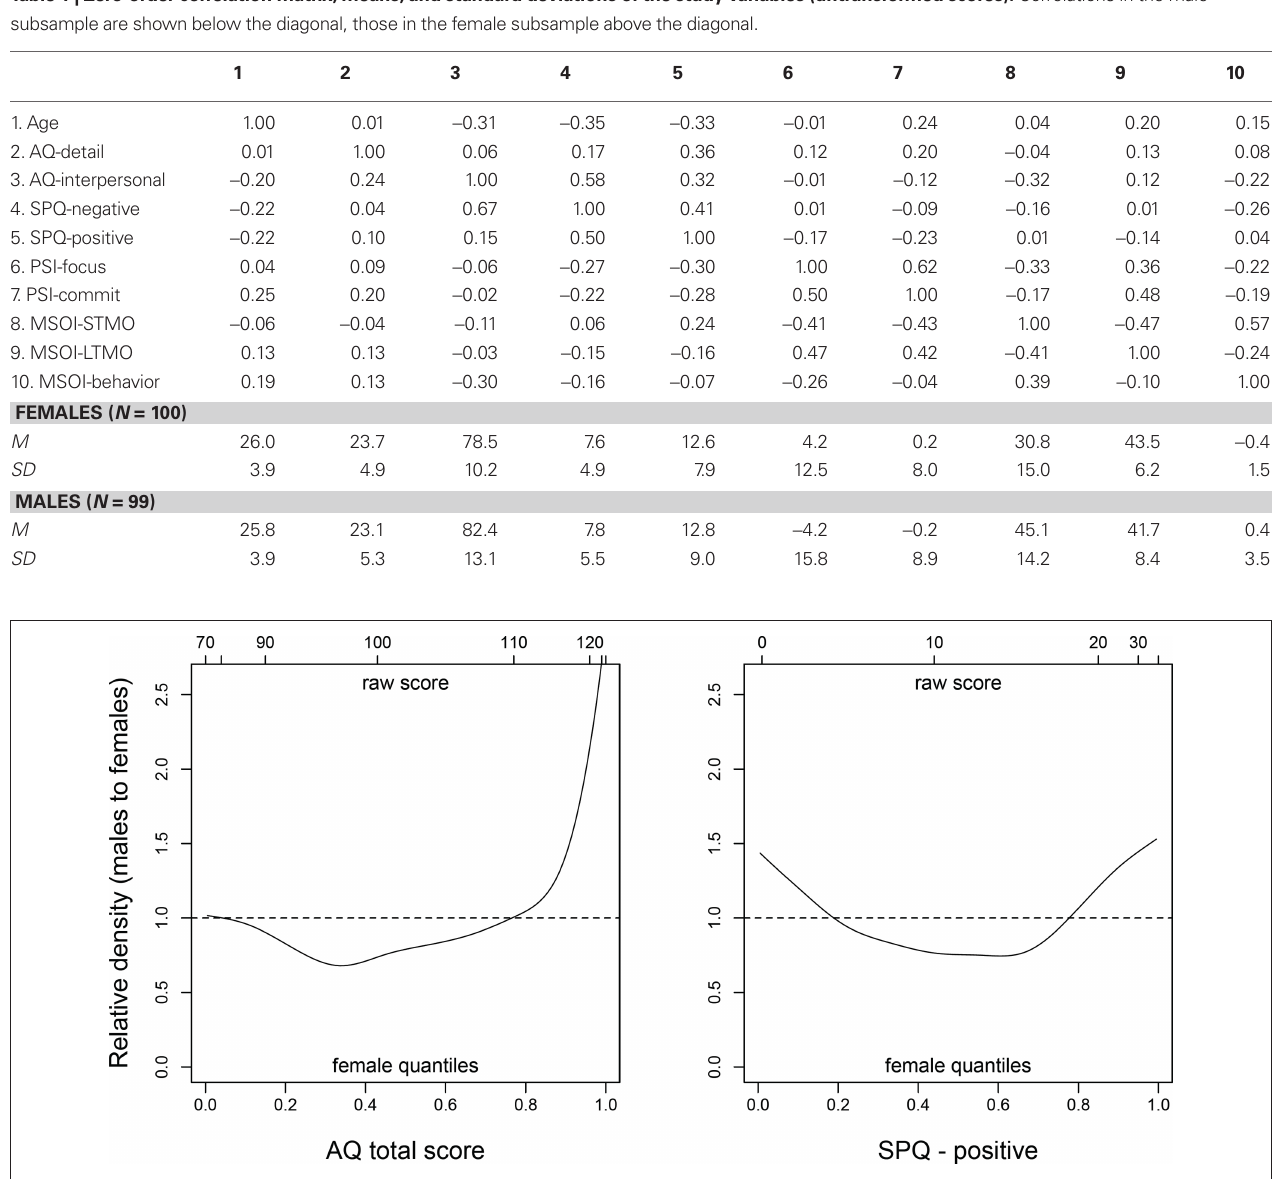
Figure 1 | relative density plots (male:female ratio) of autistic-like and positive-schizotypal traits. Dashed lines indicate equal proportions of males and females. In both cases, males are over-represented at the high end of the